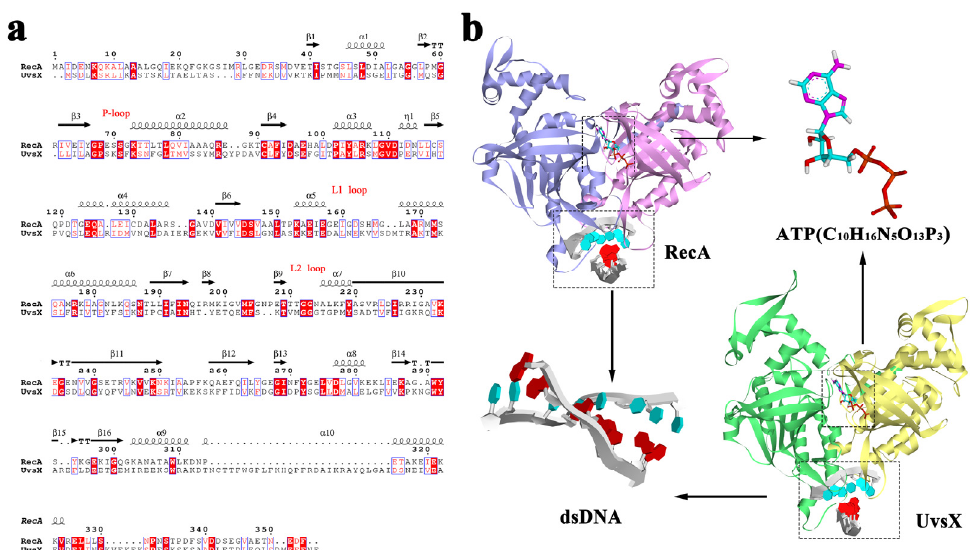
Figure 1. ( a ) Sequence alignment of RecA and UvsX. Regions with the same amino acid sequence are filled with red background, and regions with similar amino acids are filled with red letters. ( b ) Overview of initial structures included simulated initial structure of RecA, ATP structure, dsDNA structure and simulated initial structure of UvsX.